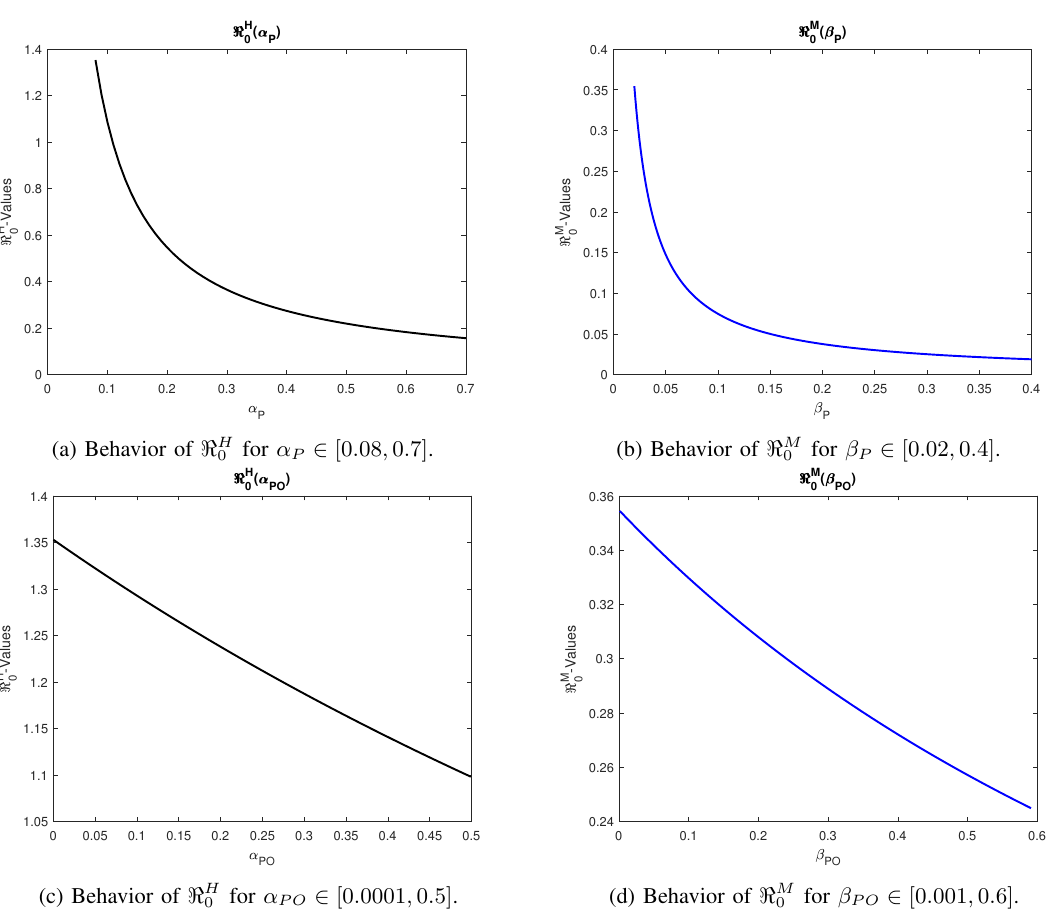
Fig. 4: Behavior of the basic reproduction number with respect to the parameters associated with the use of PrEP and